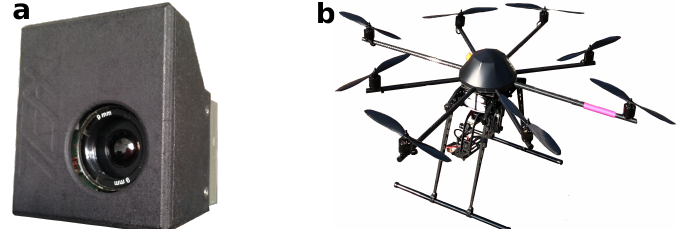
Figure 2. Image acquisition equipment. ( a ) Flir Tau 2 336 with external heated shutter system. ( b ) MK Okto XL